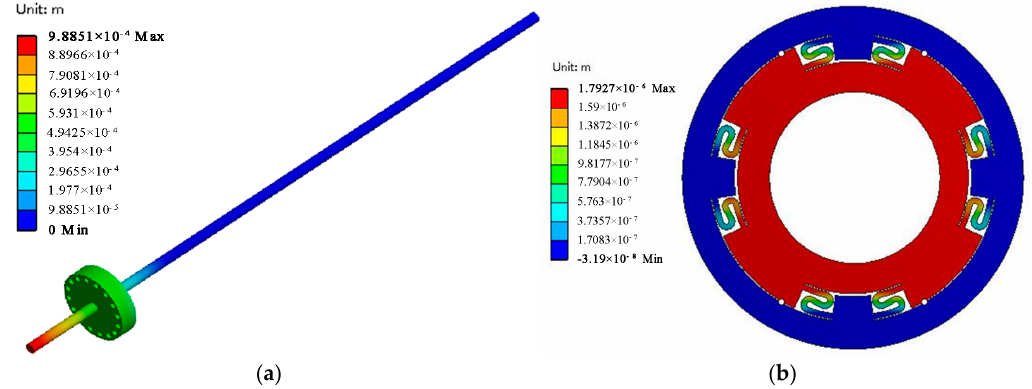
Figure 7. Displacement contour: ( a ) Shaft displacement contour; ( b ) ISFBD displacement contour.